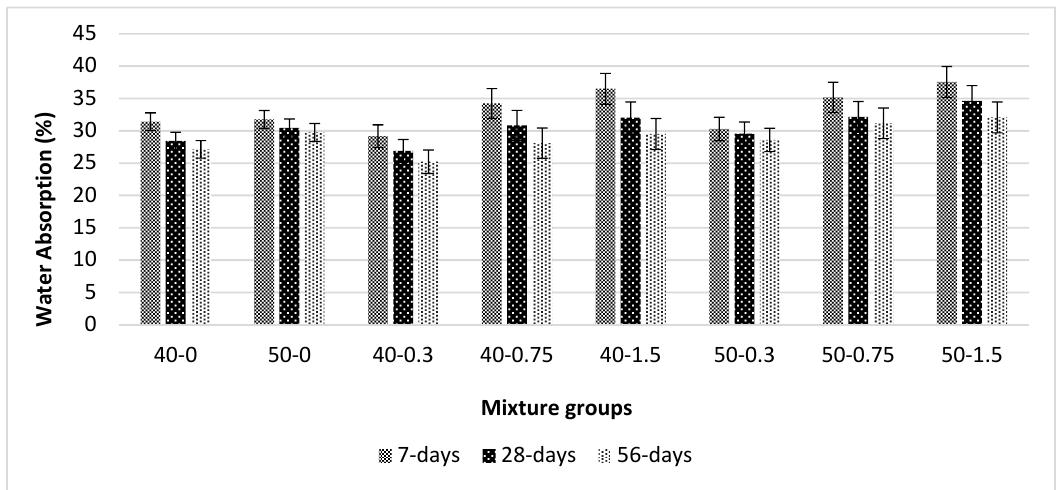
Figure 6. Water absorption values for basalt-reinforced bottom ash cement paste composites at 7, 28 and 56 days of curing.